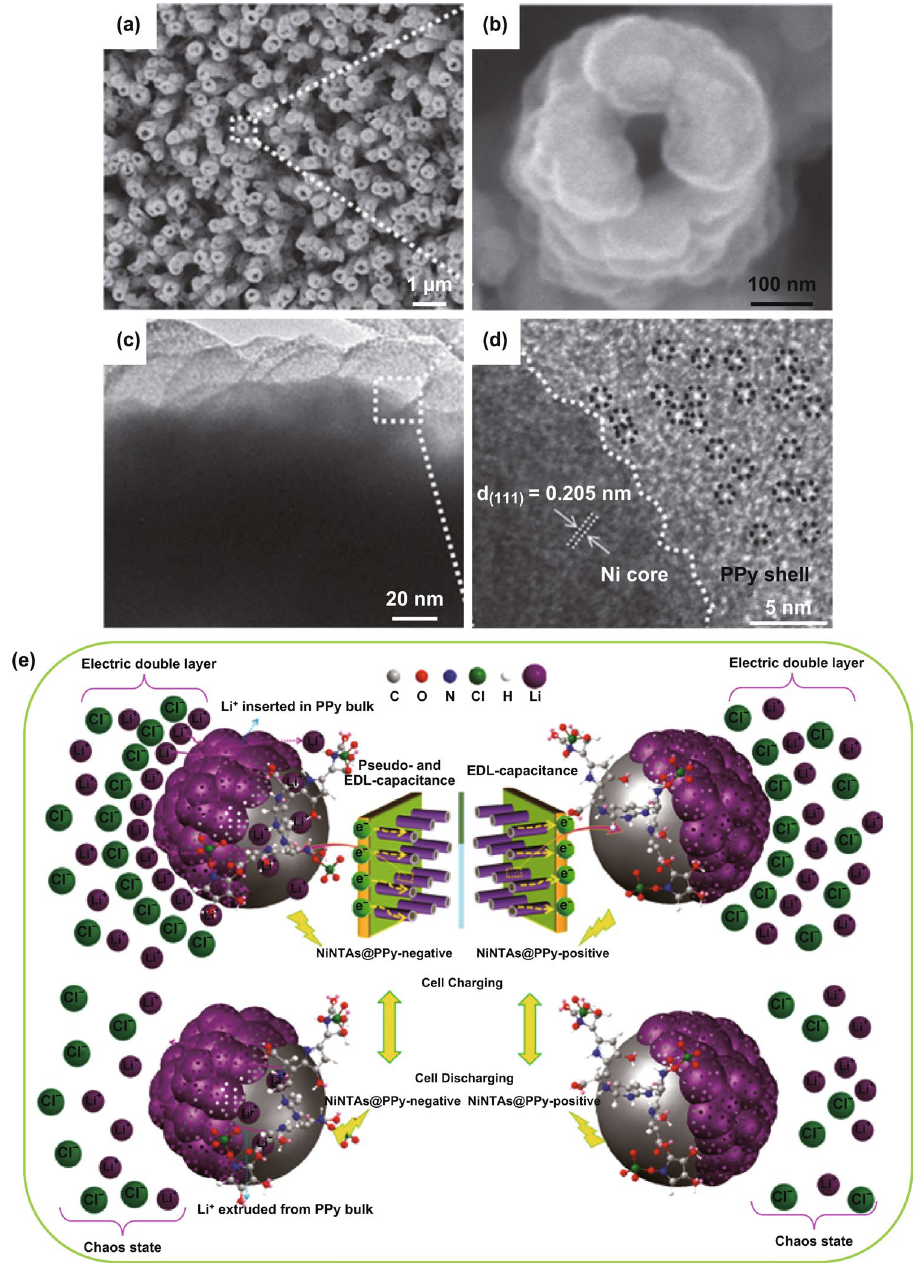
Fig. 14 a , b SEM and c , d TEM images of NiNTAs@PPy. The black dotted circles in d highlight micropores in PPy. e Schemes showing the charge storage mechanism of NiNTAs@PPy in supercapacitors during (top) charging and (bottom) discharging. Adapted from Ref. [157] with